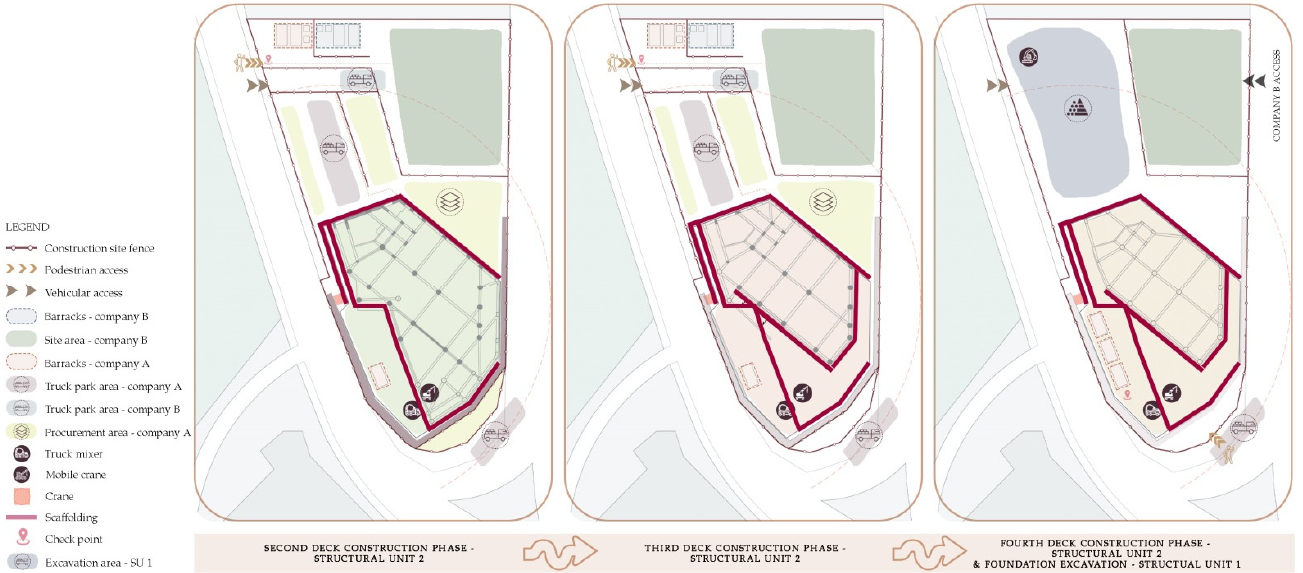
Figure 6. Second, third and fourth deck construction and foundation excavation structural unit 1 layouts—Case study.